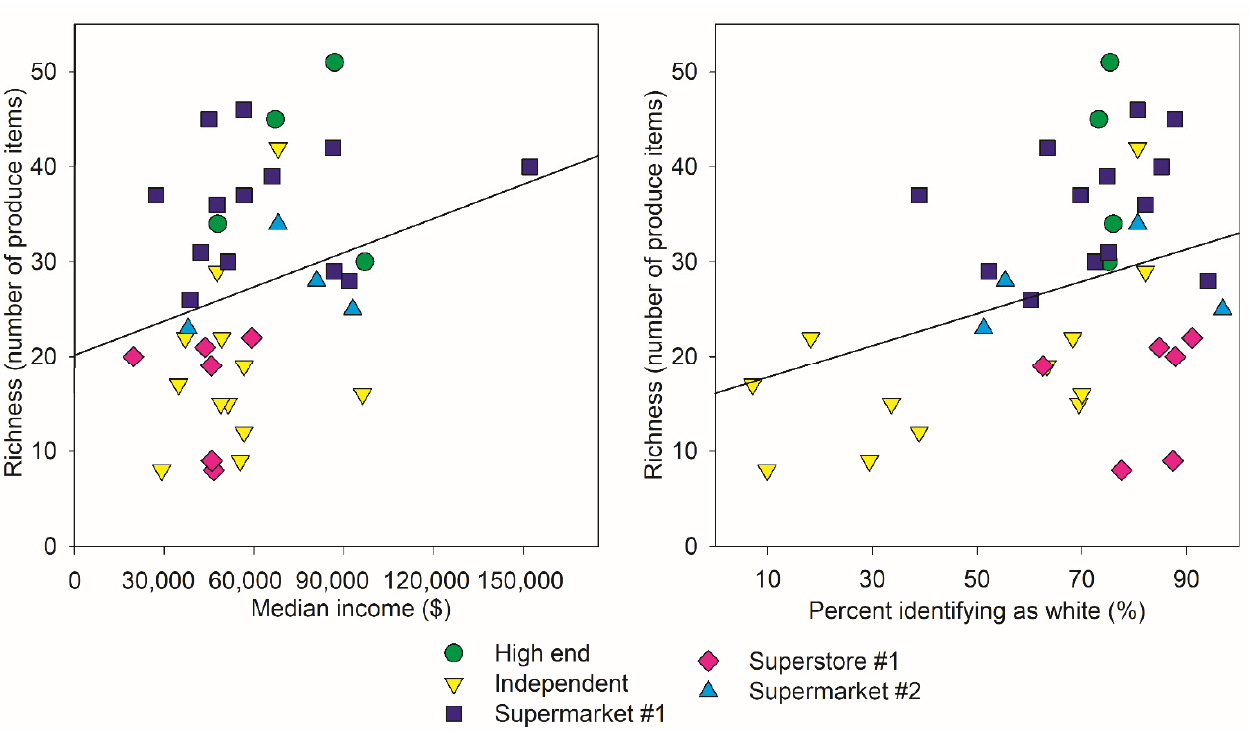
Figure 3. The relationship of Income and Percent White with Produce Diversity. Left: Median annual income of neighborhood plotted against species richness of the store. The line represents the outcome of the multiple regression (holding percent white constant). Right: Percent of population identifying as white plotted against species richness in store. The line represents the outcome of the multiple regression (holding median income constant).